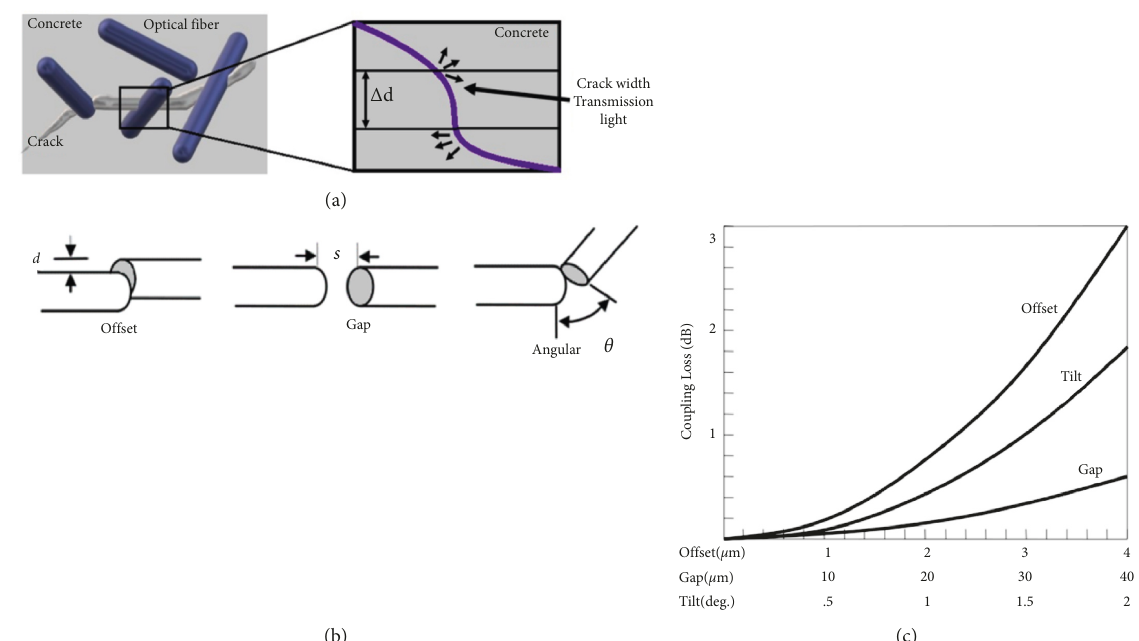
Figure 13: (a) Optic-fiber bending sensing. (b) Three types of misalignments that can occur between optic fibers. (c) Coupling loss as a function of transverse (offset), angular (tilt), and axial (gap) misalignment for optical fiber.